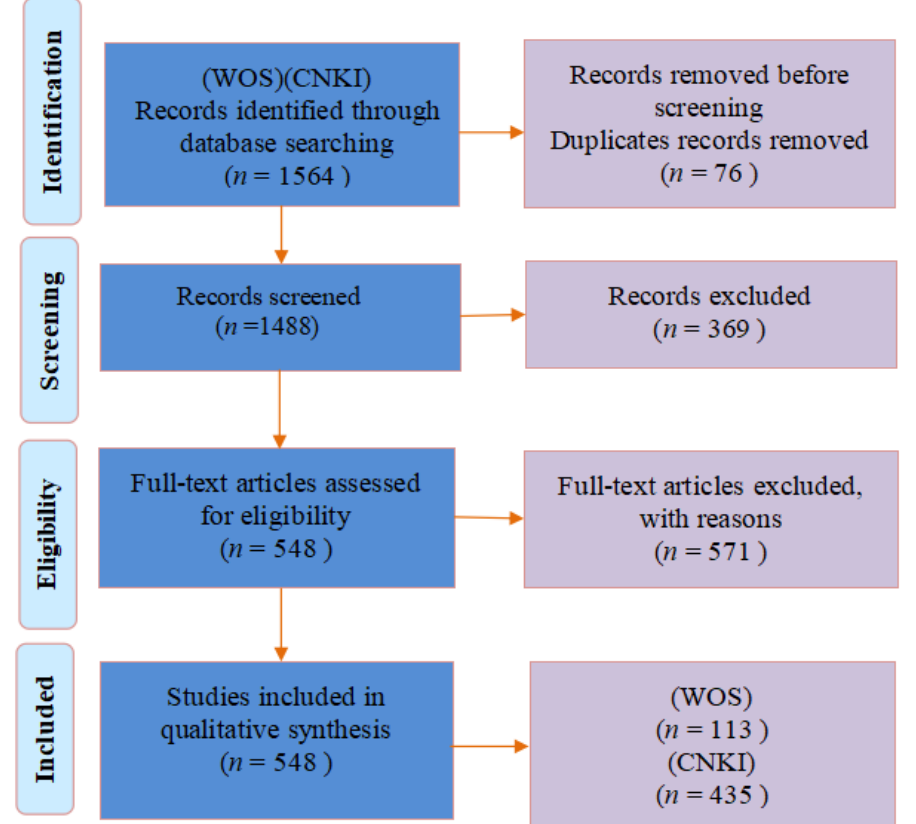
Figure 1. The process of the literature search and screening.